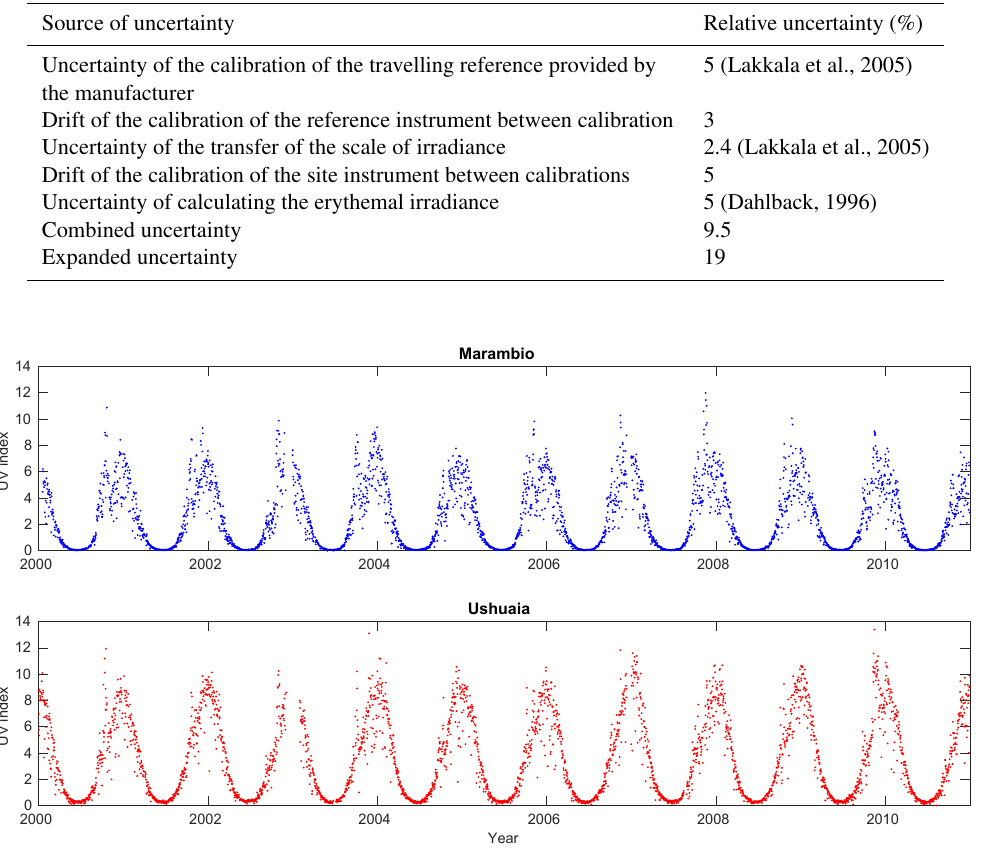
Figure 4. Daily maximum UV index measured at Marambio and Ushuaia during 2000–2010.